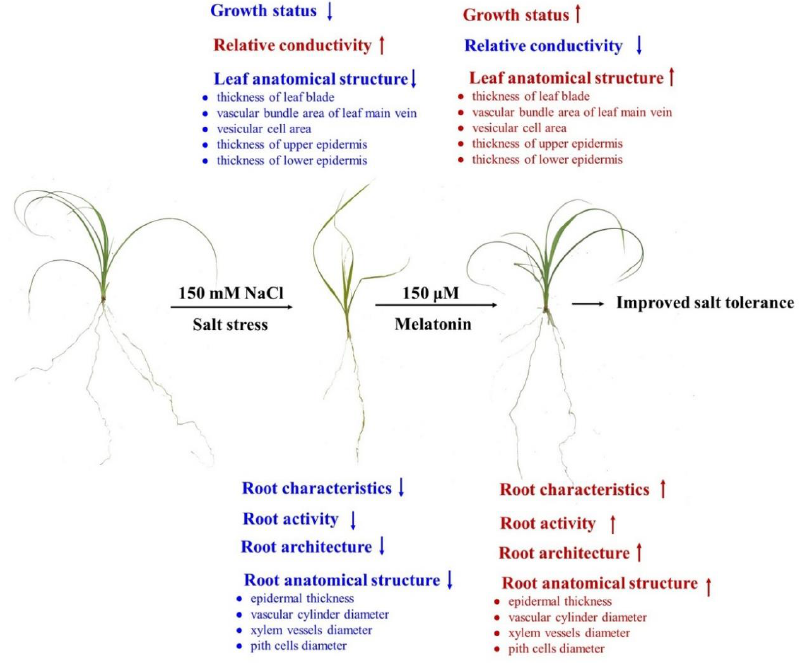
Figure 6. A proposed model showing how melatonin ameliorates salt stress in C. leucochlora seed- lings.